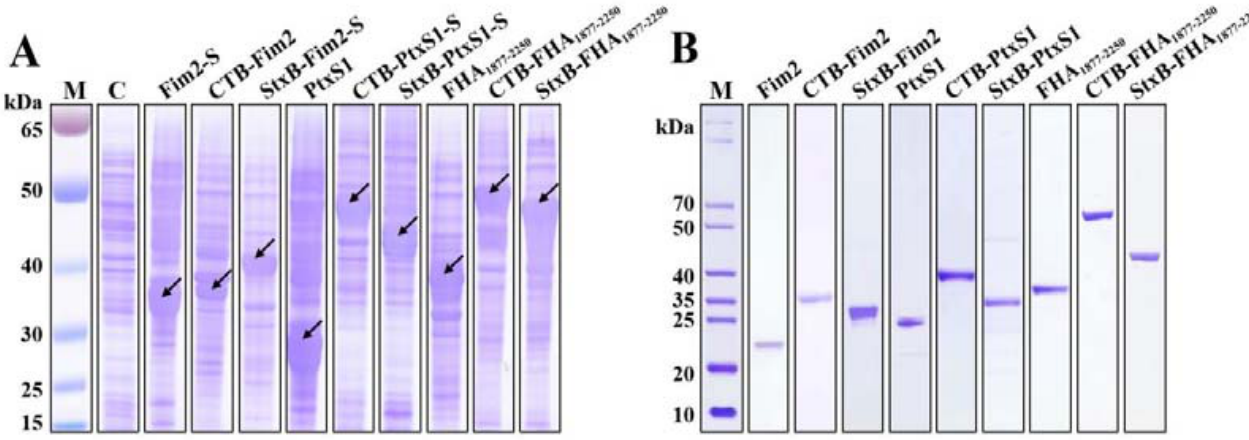
Figure 1. Expression and purification of the recombinant proteins. ( A ) Various recombinant vectors were transformed into E. coli BL21, and IPTG was used for induction of protein expression before SDS-PAGE was conducted on cell lysates Coomassie blue staining was performed to analyze the expression of the recombinant proteins. Lane C contains a BL21 strain lacking an expression plasmid that was processed via the same method (negative control). ( B ) The corresponding proteins were purified from the strains with expression plasmids, and the attached SUMO tags (if present) were removed by SUMO-specific proteases. The proteins were then separated by SDS-PAGE and analyzed by Coomassie blue staining.